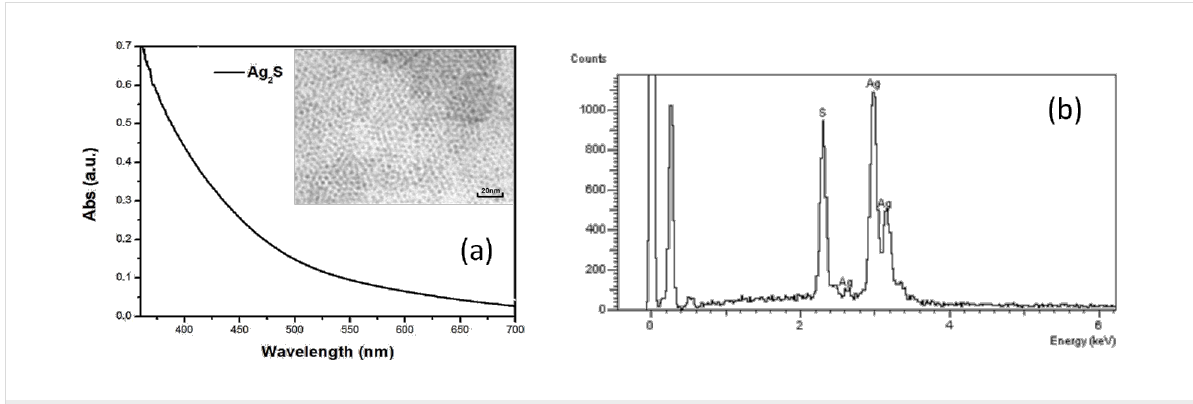
Figure 1: (a) Absorption spectra of Ag 2 S QDs in chloroform, the TEM image of Ag 2 S QDs is shown in the inset. (b) EDS spectra of Ag 2 S